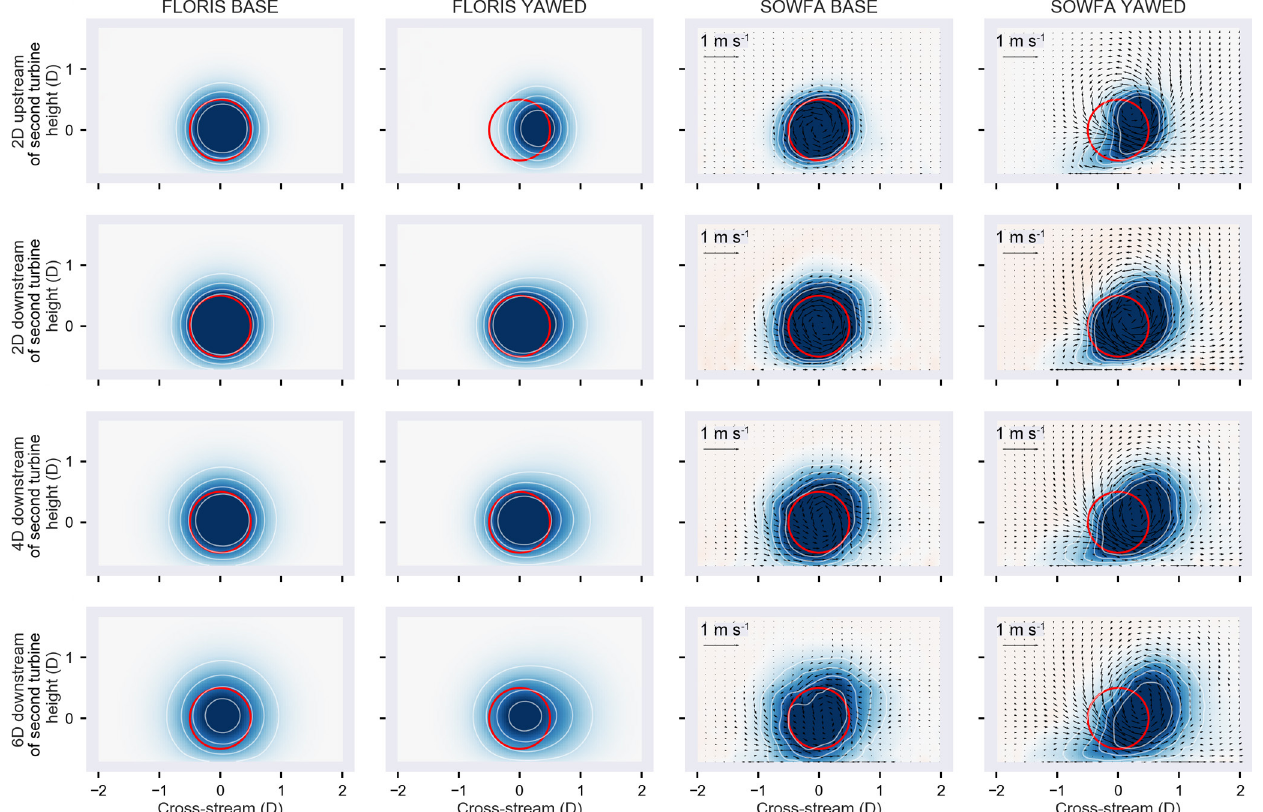
Figure 7. Cut-through visualizations of FLORIS and SOWFA 2 diameters (D) in front of second turbine (top row) and behind the second turbine (remaining